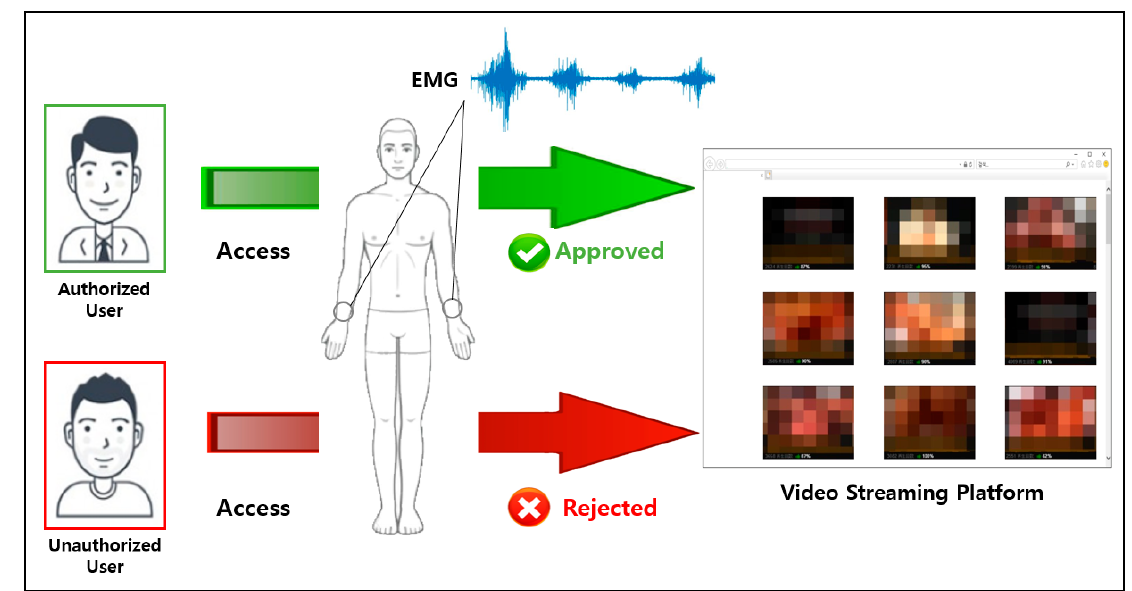
Figure 1. Block harmful genre content through user recognition.